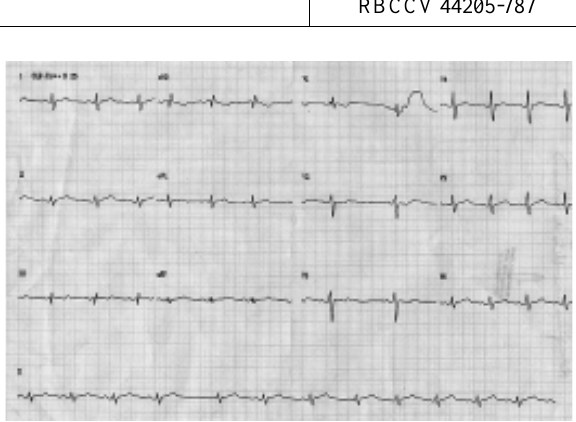
Fig. 1 - Eletrocardiograma pré-operatório ECOCARDIOGRAMA Situs solitus em levocardia. Conexões veno-atrial, átrio- ventricular e ventrículo-arterial concordantes. Conexão das veias pulmonares no átrio esquerdo caracterizada pelo fluxo das veias pulmonares superiores direcionado para a veia cava superior e átrio direito. Comunicação interatrial tipo seio venoso subcaval de 21 mm em seu maior eixo. Dilatação do tronco e ramos pulmonares. Ao Doppler havia regurgitação tricúspide discreta, pressão sistólica em ventrículo direito de 39 mmHg e QP/QS de